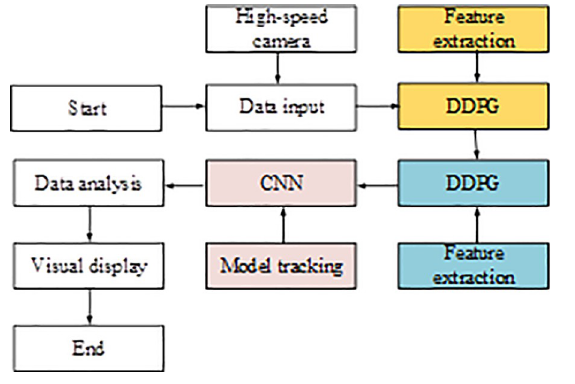
Fig 6. Structure of table tennis trajectory